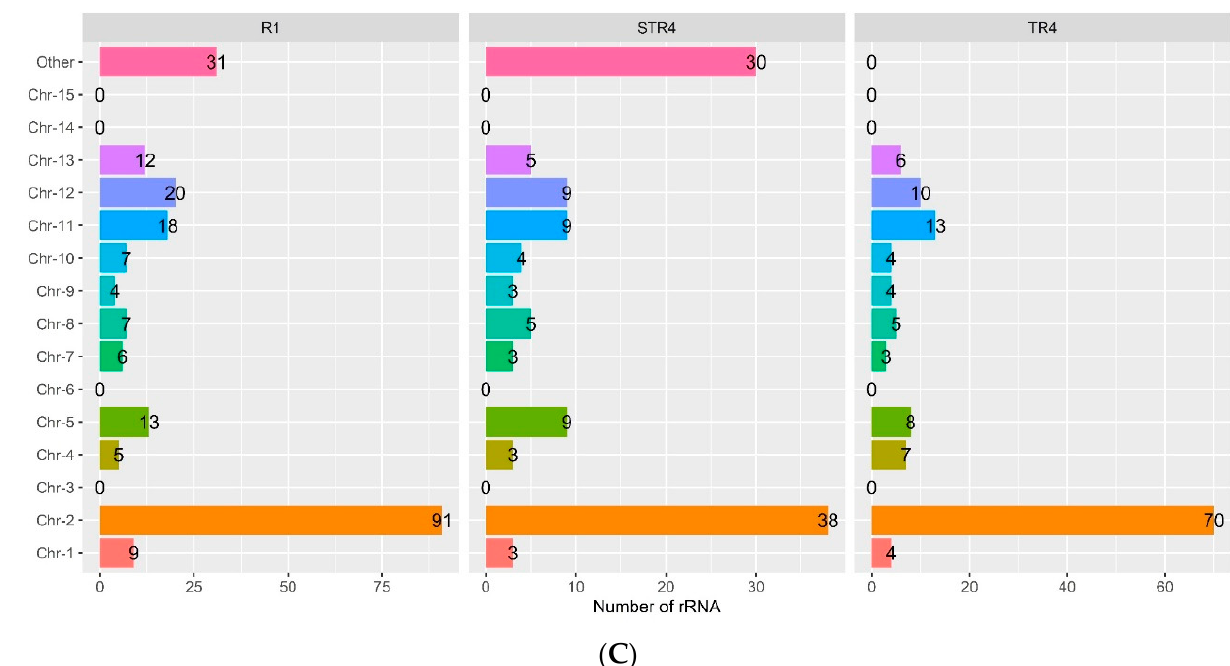
Figure 1. Comparison of the distribution pattern of protein-coding genes ( A ), tRNA ( B ) and rRNA ( C ) in the Indian VCGs of Foc genome assemblies. The colour in the bar chart represents the respective chromosome and the value in the bar are the number of occurrences.